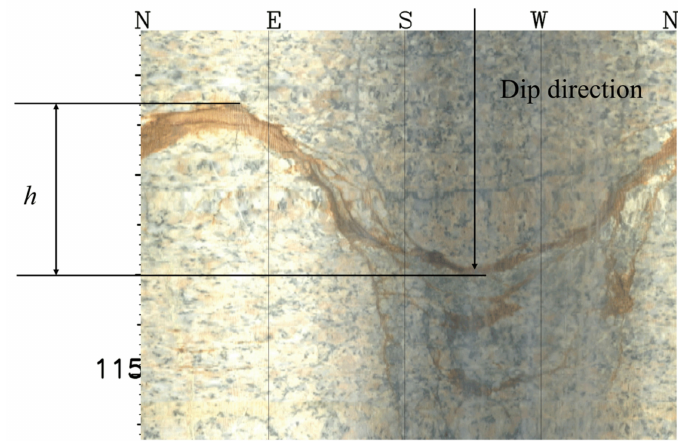
Figure 2. Structural plane in the expanding image of borehole wall.